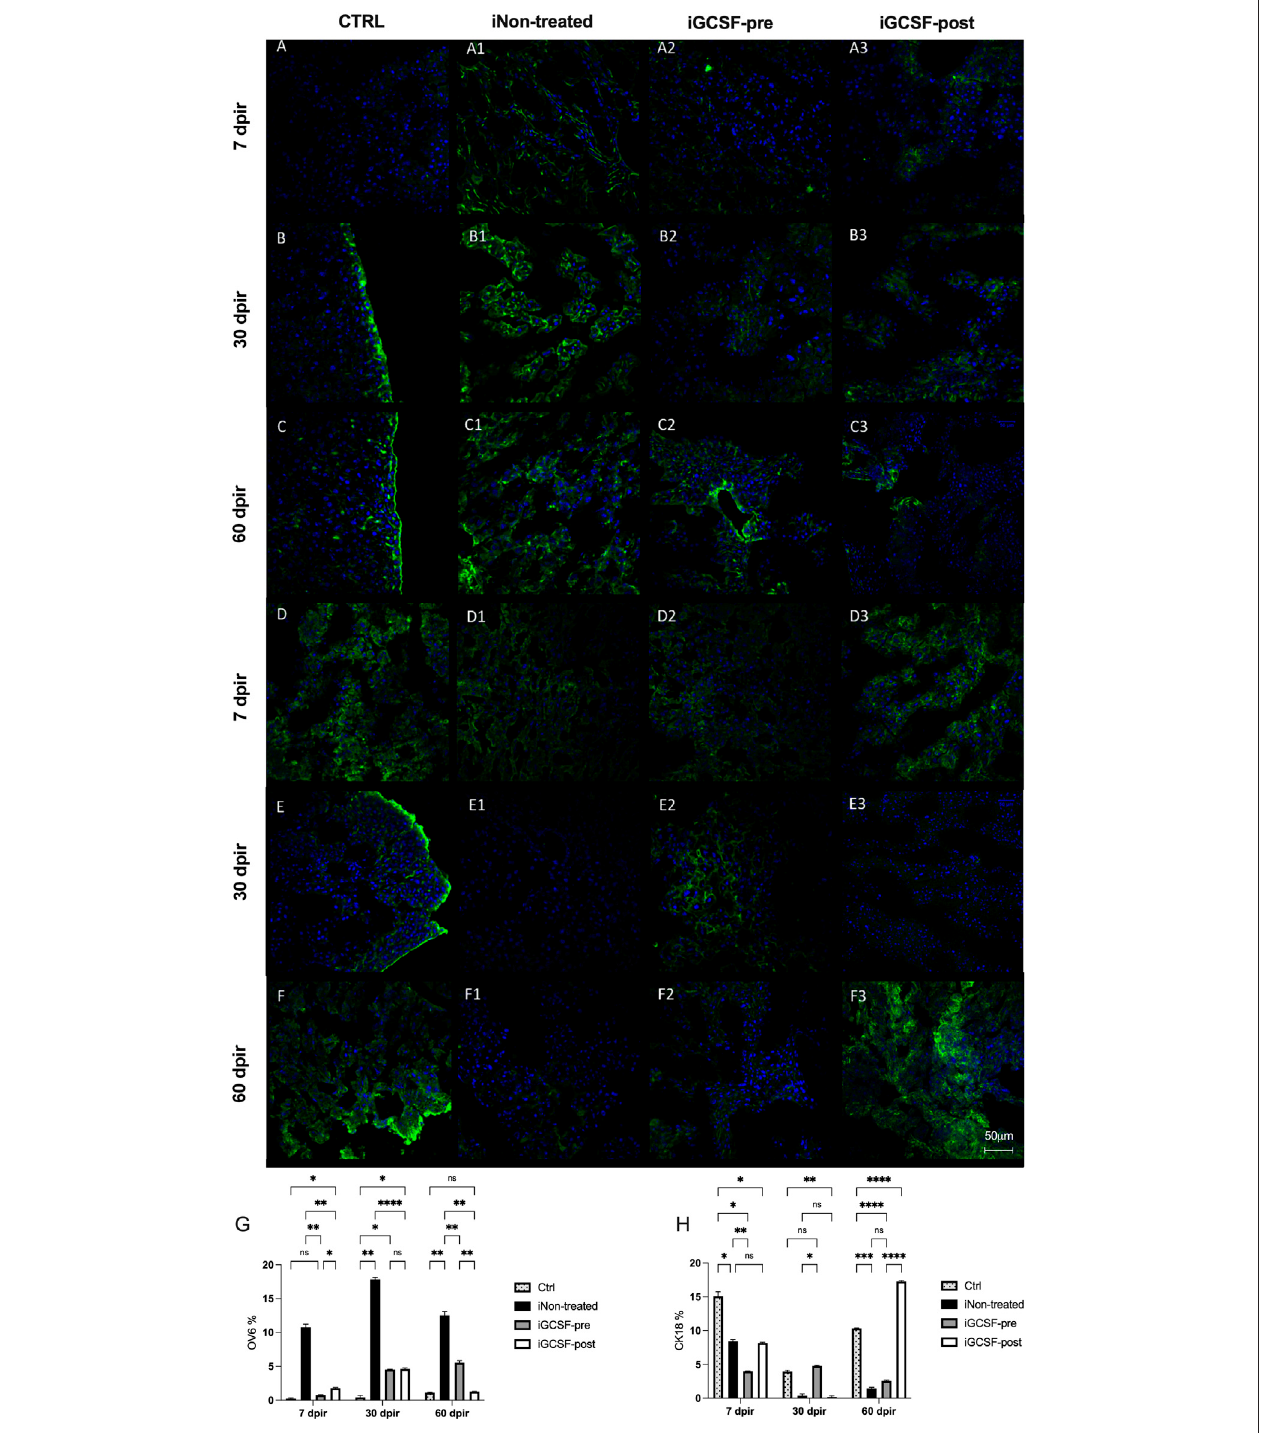
FIGURE9| Liverstemcell(OV-6)andcytokeratin-18(CK18)proteinexpressionevaluation.RepresentativeimagesofOV-6andCK-18immunostainingfromCTRL (A – C,D – F) , iNon-treated (A1 – C1,D1 – F1) , iGCSF-pre (A2 – C2,D2 – F2) and iGCSF-post group (A3 – C3,D3 – F3) at 7, 30- and 60-day post-irradiation. Immunostaining imagesrevealedlowOV-6proteinexpressioninCTRLgroup (A – C) .IniNon-treatedGroup (A1 – C1) ,anincreaseinOV-6proteinexpressionwasobservedatallanalyzed times. In iGCSF-pre Group (A2 – C2) , a remarkable increase in OV-6 protein expression was observed. Similarities regarding OV-6 protein expression